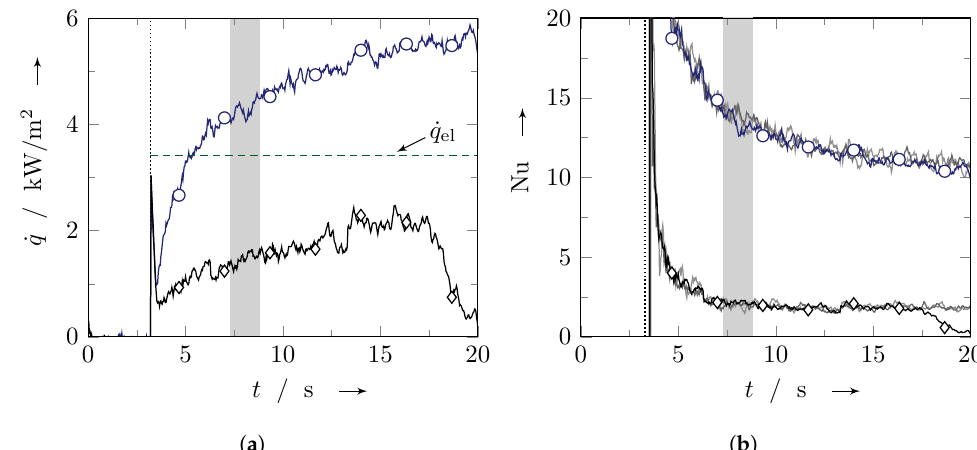
Figure 5. Transient results for the specific heat flux and the Nusselt number in a pixel in the stagnation point of an impinging jet ( ) and in a distance of 7 D from the stagnation point ( ◦ flux; ( b ) Nusselt